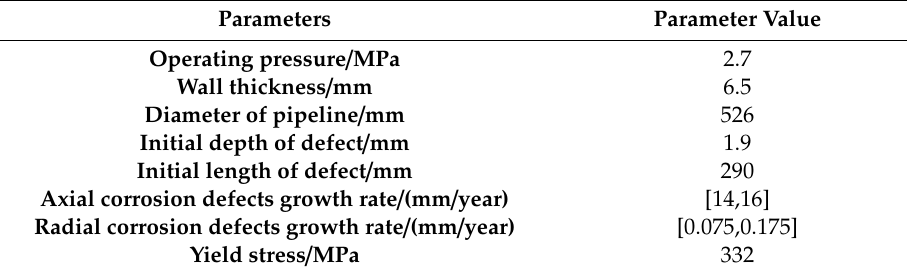
Table 2. Basic parameters of corroded pipeline.